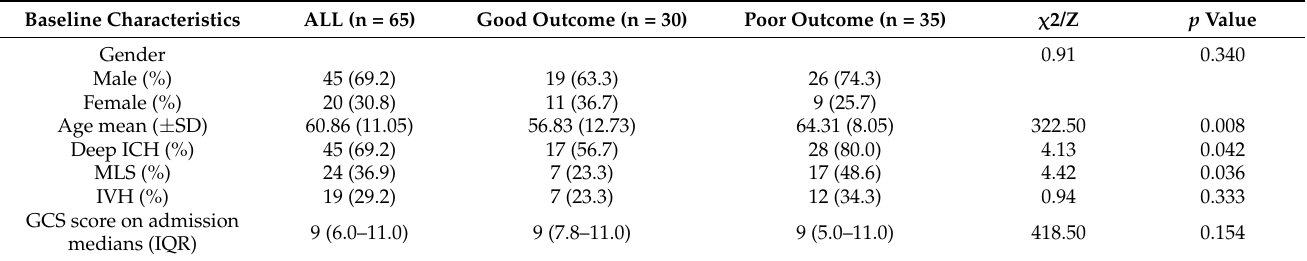
Table 2. Baseline demographic, clinical, and radiological characteristics of external test